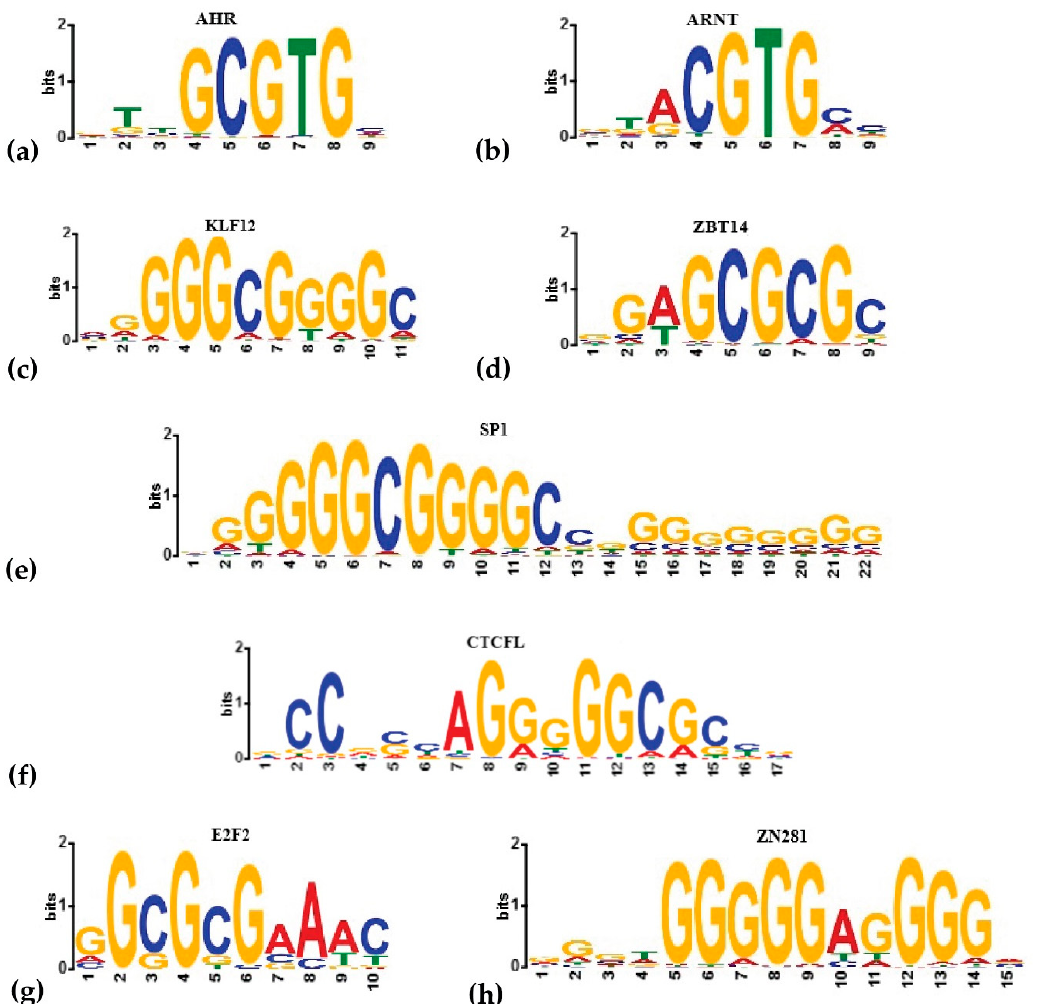
Figure 3. The binding sites of known ( a , b ) and predicted by MetaRE or HOMER ( c – h ) transcriptional regulators of the transcriptional response to dioxin. The logos were generated in the Hocomoco database [40].